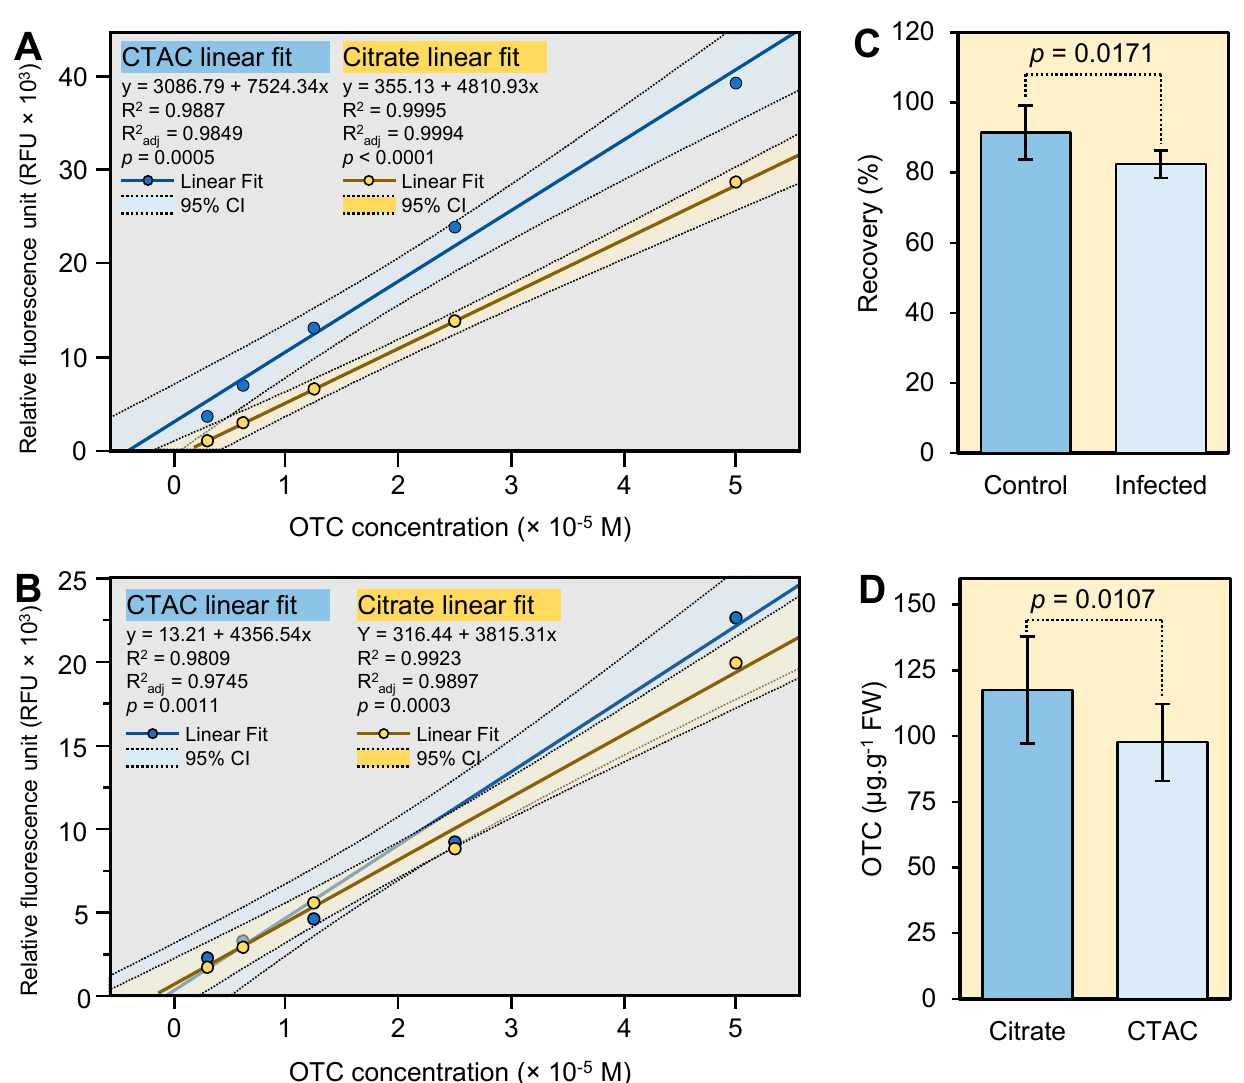
Figure 3. Recovery of OTC from spiked citrus leaf samples and application of the new method to field’s samples. ( A ) Standard curves of pure OTC prepared in 60% methanol using CTAC or citrate as a coligand. ( B ) Standard curves of OTC